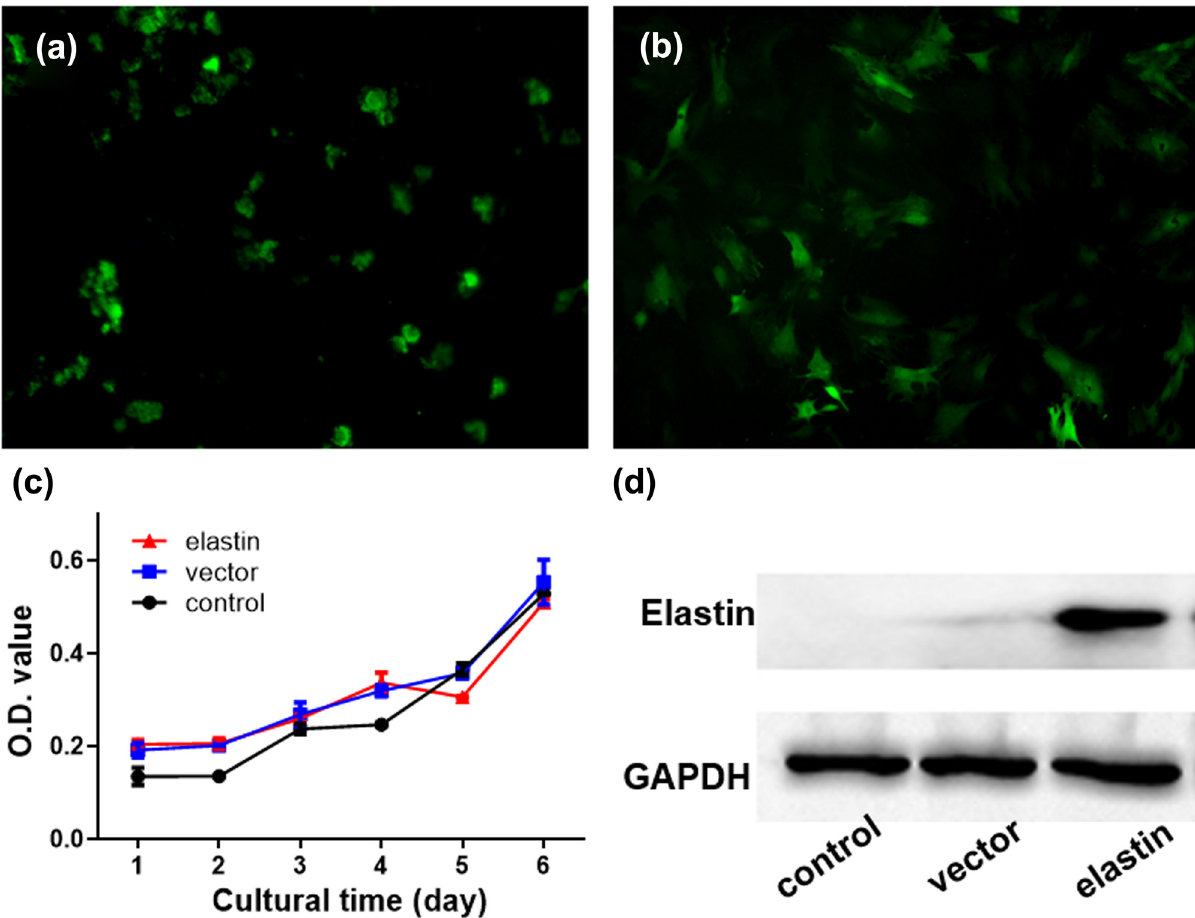
Figure 2: Green fl uorescence pictures of BMSCs treated with ( a ) pure and ( b ) gene - loaded vectors, respectively; ( c ) CCK - 8 assay of BMSCs with di ff erent treatments; and ( d ) photograph of elastin measurement with western blot experiment (× 400 )